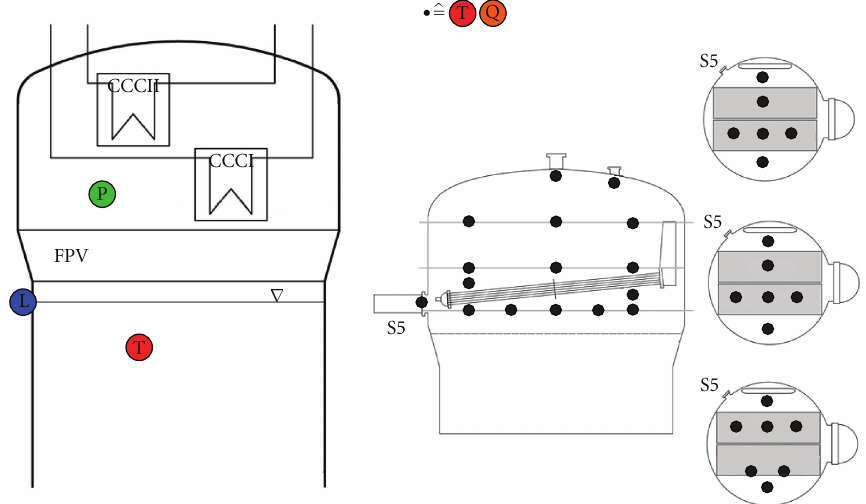
Figure 9: Instrumentation of the water space of the Flooding Pool Vessel.